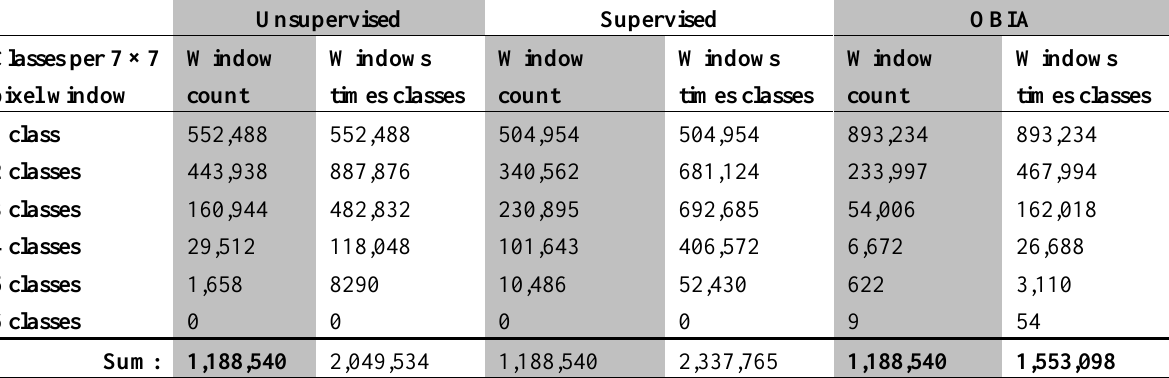
Table 5. Diversity assessment